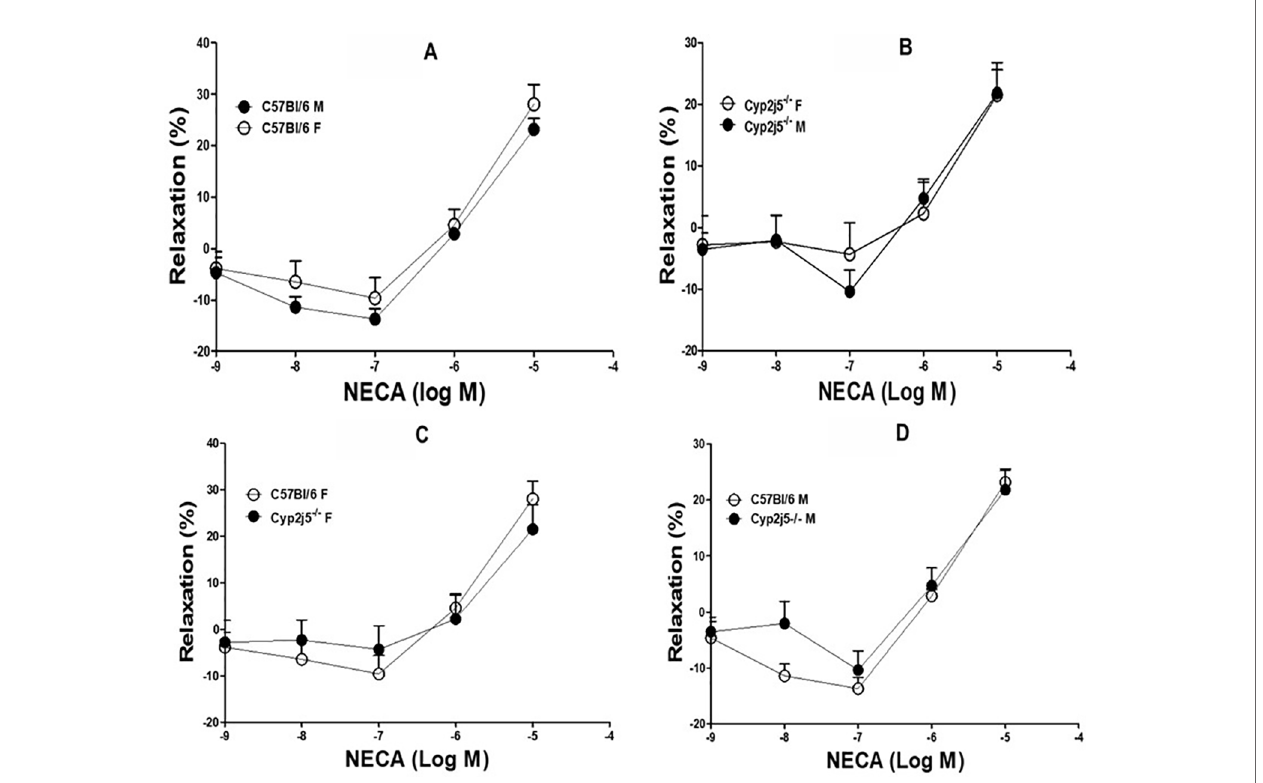
FIGURE 4 | 5'-N-Ethylcarboxamidoadenosine (NECA)-induced concentration dependent vascular response in aortic rings of C57Bl/6 and Cyp2j5 − / − mice. P > 0.05 between C57Bl/6 (M) vs . C57Bl/6 (F) mice (A) , P > 0.05 between Cyp2j5 − / − (M) vs . Cyp2j5 − / − (F) mice (B) , P > 0.05 between Cyp2j5 − / − (F) vs . C57Bl/6 (F) mice (C) and P > 0.05 between Cyp2j5 − / − (M) vs . C57Bl/6 (M) mice (D) . Values expressed as means ± SE. n = eight per